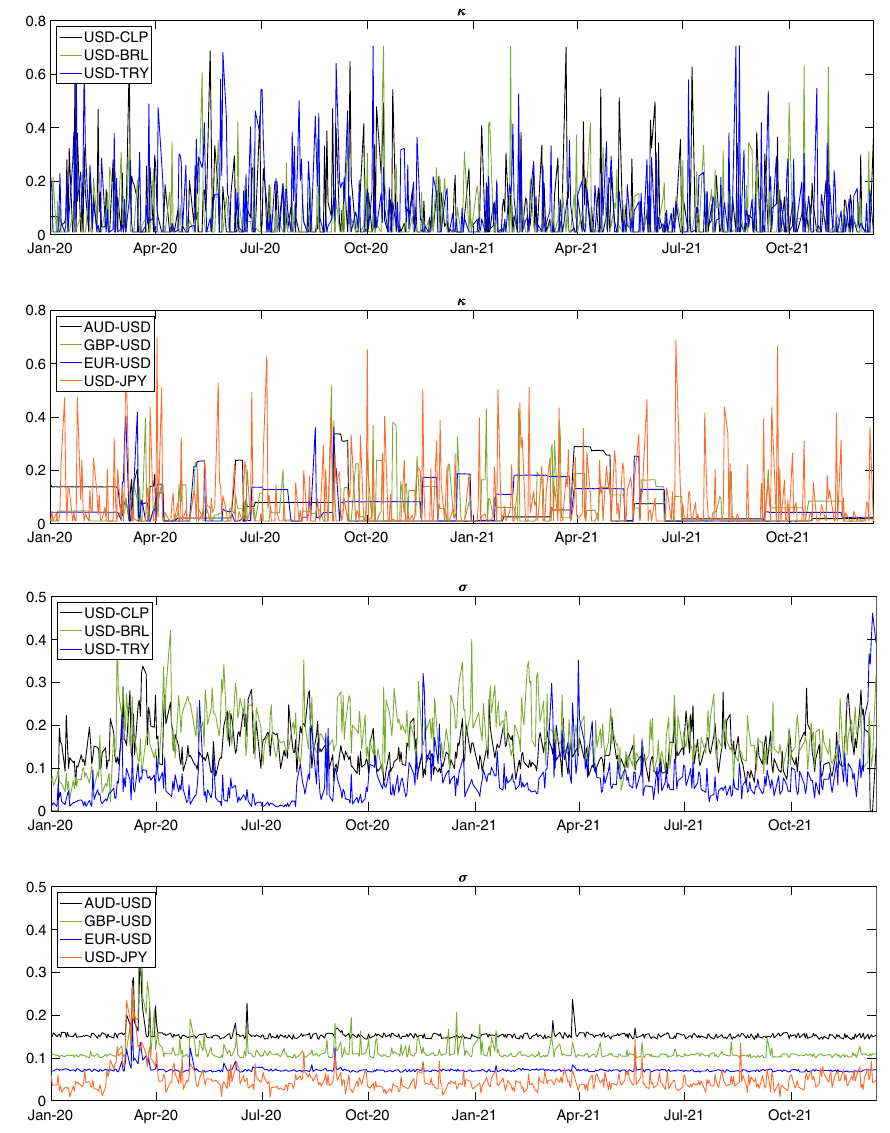
Fig. 7 κ and σ (%) estimations for the intraday price dynamics following the Vasicek model of Eq. (12). These values are obtained by calibrating the model with daily data and their average are the values shown